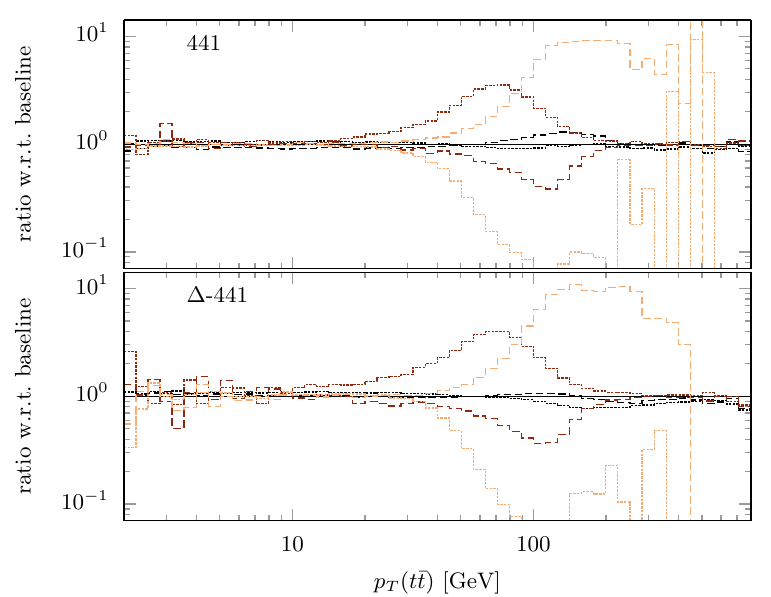
Figure 7 . Ratios of the upper and lower predictions over the baseline ones, for the two rightmost panels of the two rows in (cid:12)gure